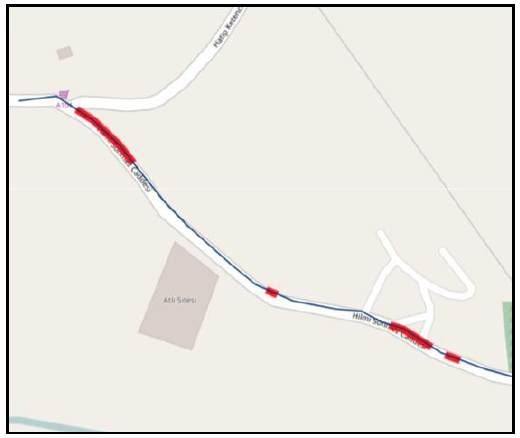
Figure 11. Display of added highway disturbance data on the map